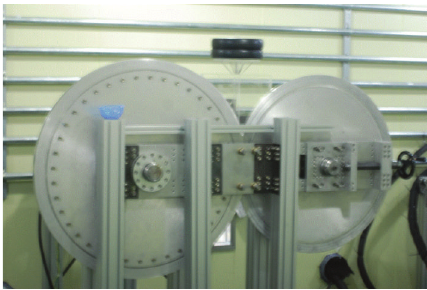
Figure 3: The lab-scale twin-roll press machine for continuous